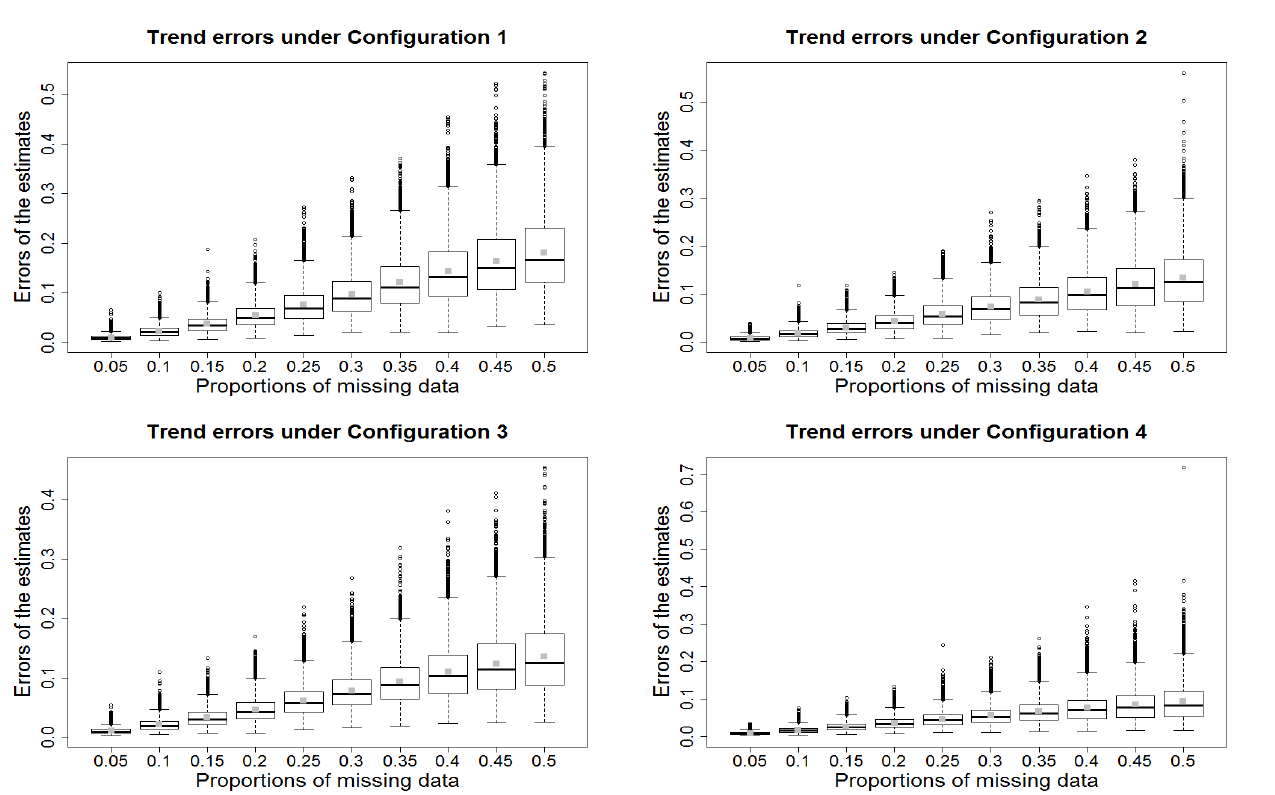
Figure 2. Boxplots of the trend errors (in squared degree Celsius) under different settings.